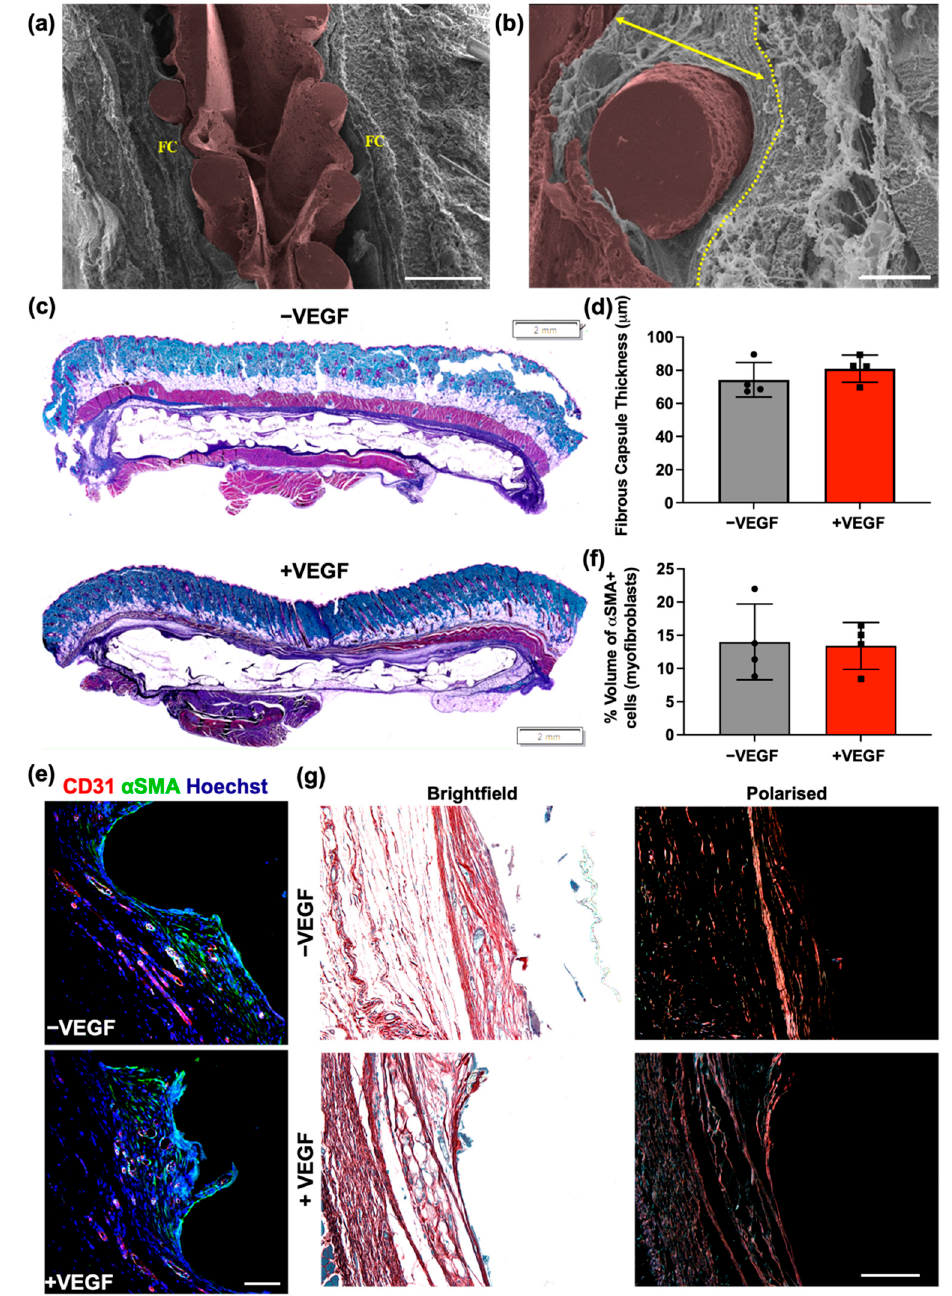
Figure 4. VEGF does not affect the structure and composition of the fibrous capsule. ( a ) Overview of encapsulation device (pseudo-coloured in brown) in-situ with surrounding fibrous capsule (FC). Scale bar = 500 µ m. ( b ) Fibrous capsule surrounding rope coil on external surface of +VEGF device. Yellow dotted line marks outer boundary of the fibrous capsule before muscle layer. Arrow demonstrates where an FC measurement would have been taken, perpendicular to the tissue–device interface. Scale bar = 100 µ m. ( c ) Representative Masson’s trichrome-stained histological sections of − VEGF and +VEGF groups. Scale bar = 2 mm. ( d ) Mean fibrous capsule thicknesses. ( e ) Representative immunofluorescent images of myofibroblasts within the surrounding fibrous capsule (Hoechst, blue; α SMA, green; CD31, red). ( f ) Percentage volume of α SMA+ cells (myofibroblasts) within the fibrous capsule. ( g ) Representative polarised light microscopy images for analysis of the fibrous capsule and collagen maturity at the tissue–device interface. Scale bar = 100 μ m. (Red/Orange = mature collagen; Green/Yellow = immature collagen). n = 4 per group, data are represented as means ± SD.